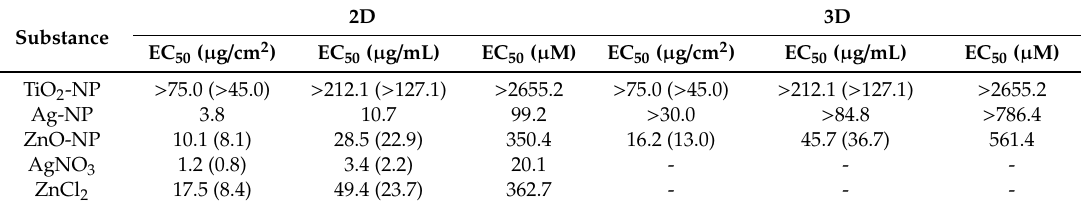
Table 5. EC 50 values from alamarBlue assay in HepG2 2D and 3D cultures after 24 h exposure to TiO 2 -NPs, Ag-NPs or ZnO-NPs. EC 50 values of metal compartments are given in